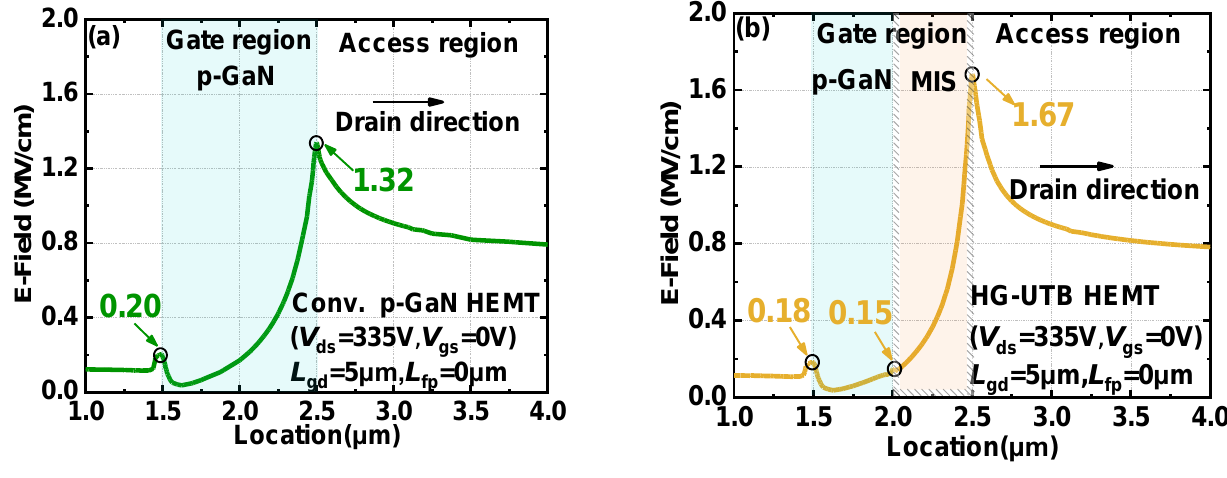
Figure 7. Distribution of E-field beneath the gate region in reverse blocking with a drain bias of 335V of ( a ) conventional p-GaN gate HEMTs and ( b ) HG-UTB